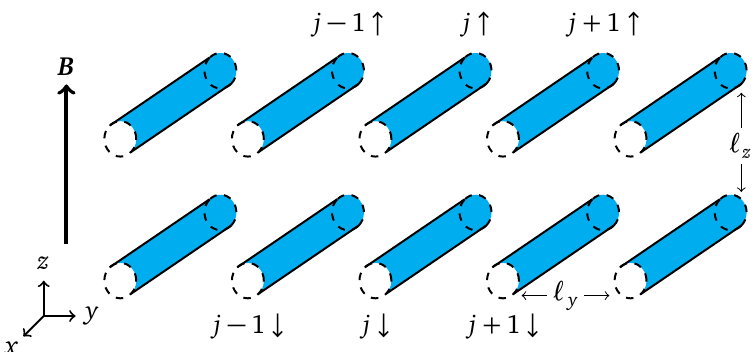
Figure 2: The coupled-wire bilayer model. Each wire is labelled by a wire number j and a layer index σ = ↑ , ↓ , the distance between adjacent wires within a layer is (cid:96) with b = eB (cid:96) . Here, m is the effective mass, e < 0 denotes the electron charge, and B > y